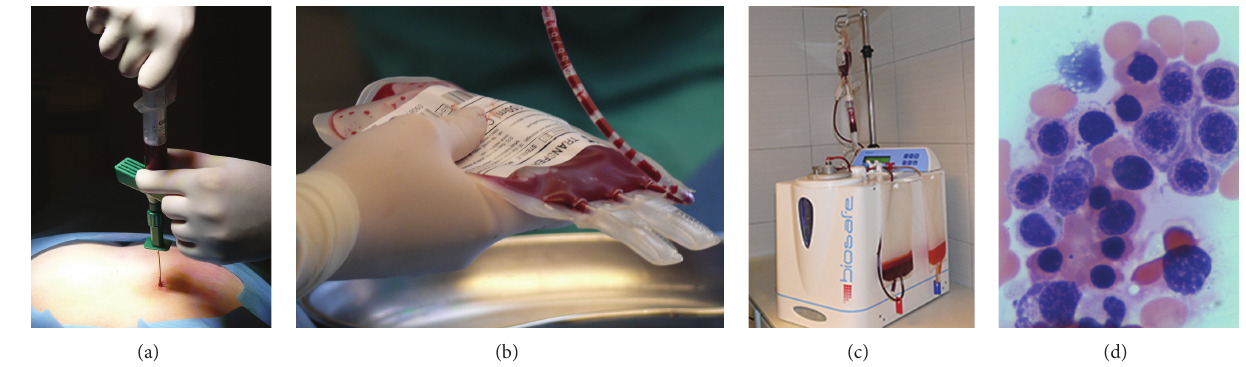
Figure 1: Bone-marrow-derived mononuclear cells preparation: (a) the bone marrow harvesting from posterior iliac crest, (b) collection of bone marrow in plastic bag, (c) the bone marrow processing by using Cell Separation System SEPAX S-100, and (d) qualitative assessment of BMMNCs population by haematoxylin and eosin cytological staining ( ×400